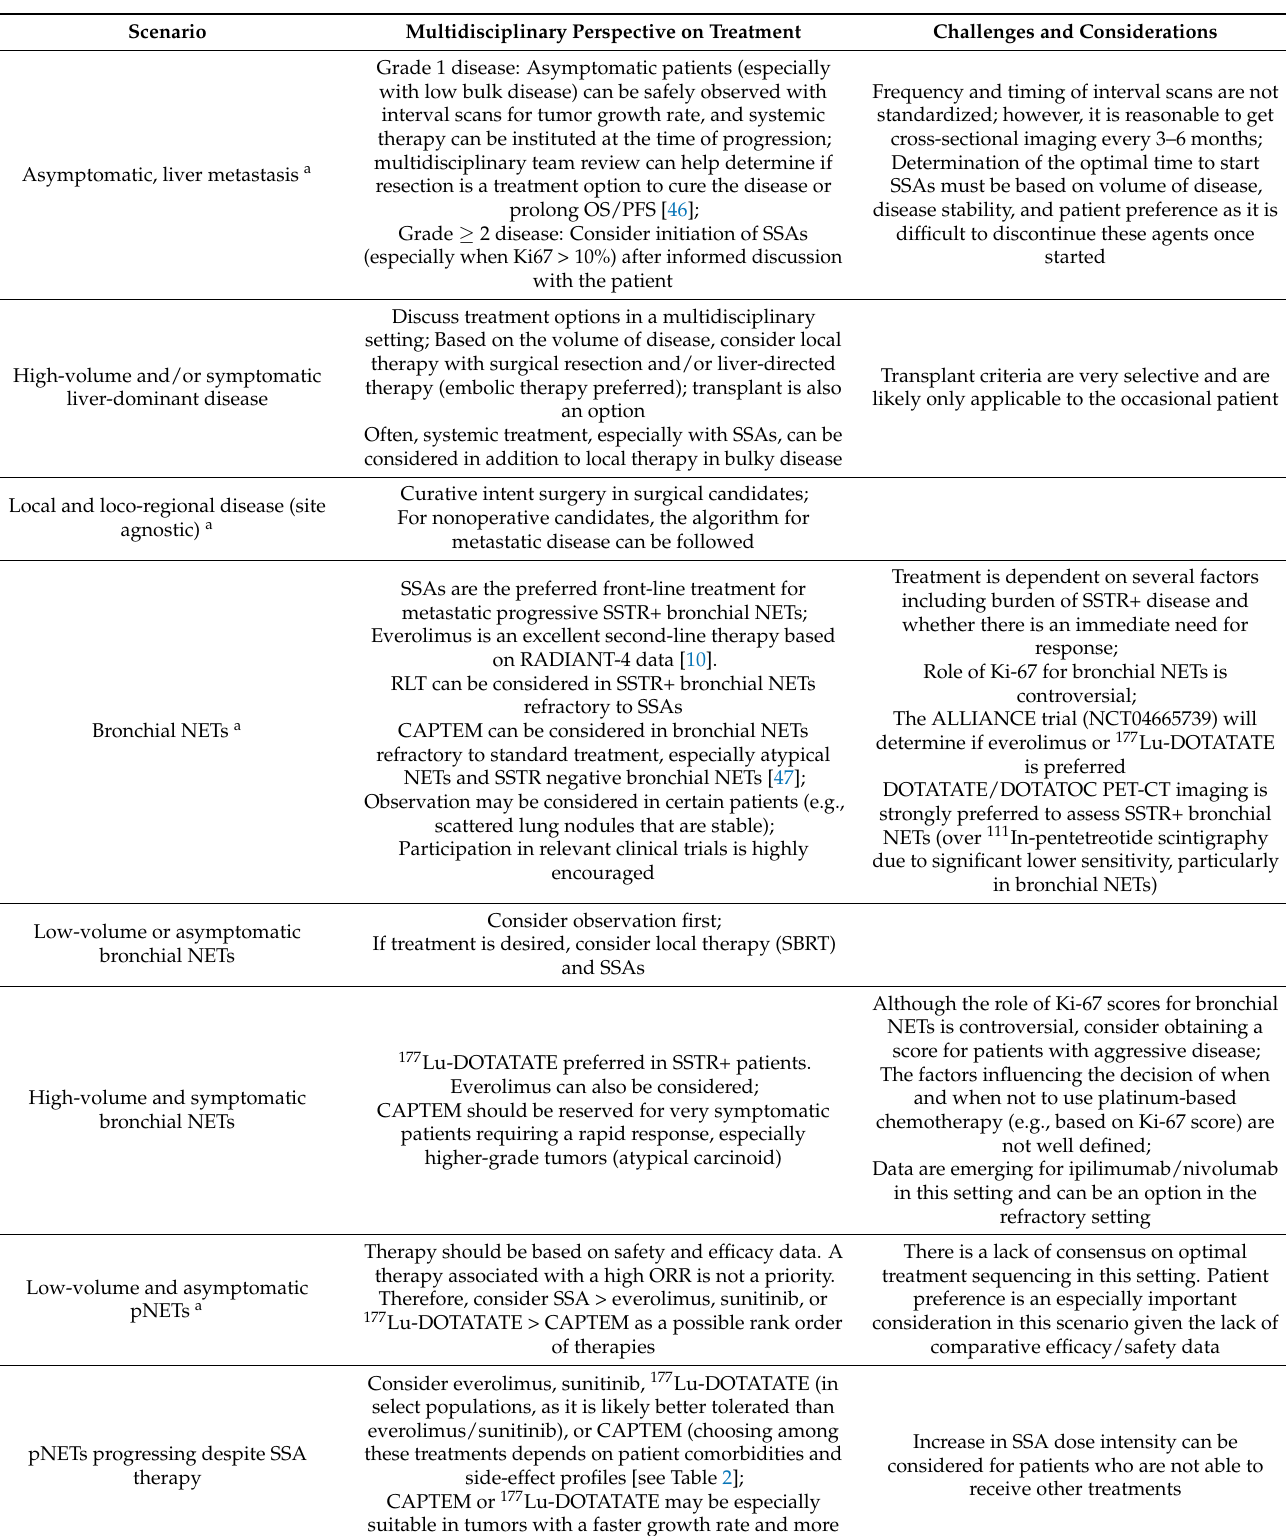
Table 3. Author opinion on treatment sequencing in advanced